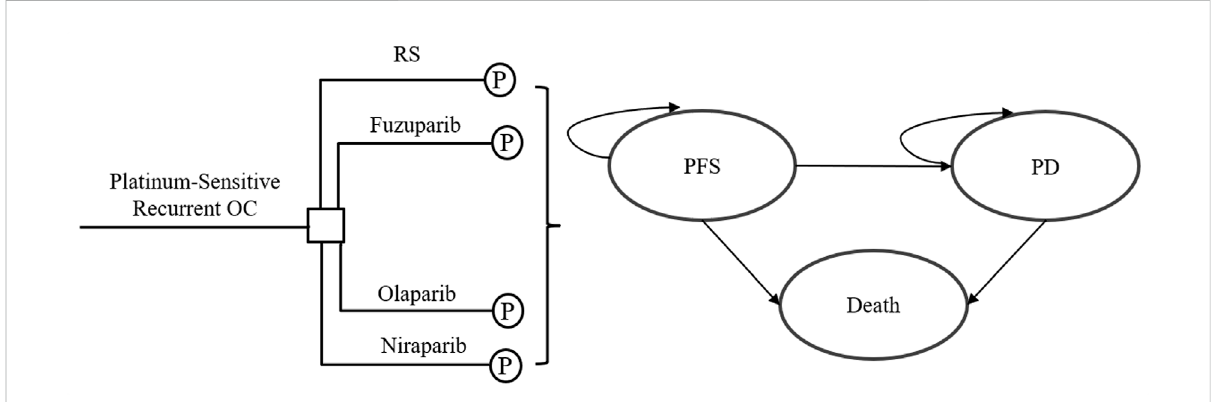
FIGURE 1 Model structure for platinum-sensitive recurrent ovarian carcinoma. OC, ovarian carcinoma; P, partitioned survival model; RS, routine surveillance; PFS, progression-free survival; PD, progressed